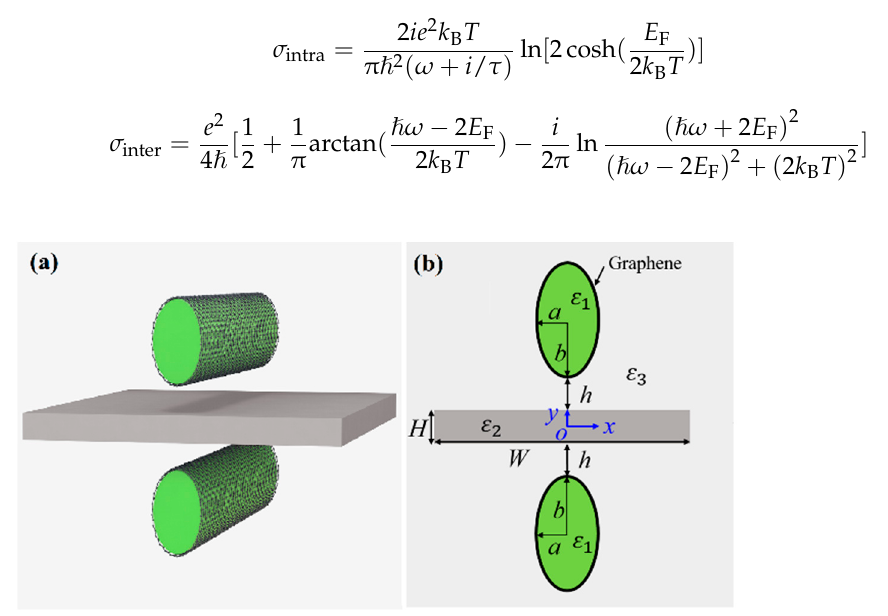
Figure 1. Schematic of the proposed SGPWG. ( a ) Three-dimensional (3D) view, ( b ) two-dimensional (2D)